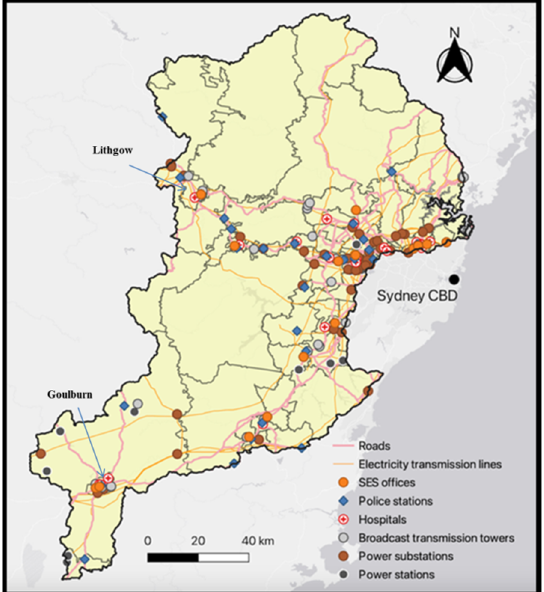
Figure 6. A map of critical infrastructure in the Hawkesbury-Nepean Catchment at SA2 (generated using QGIS 3.24